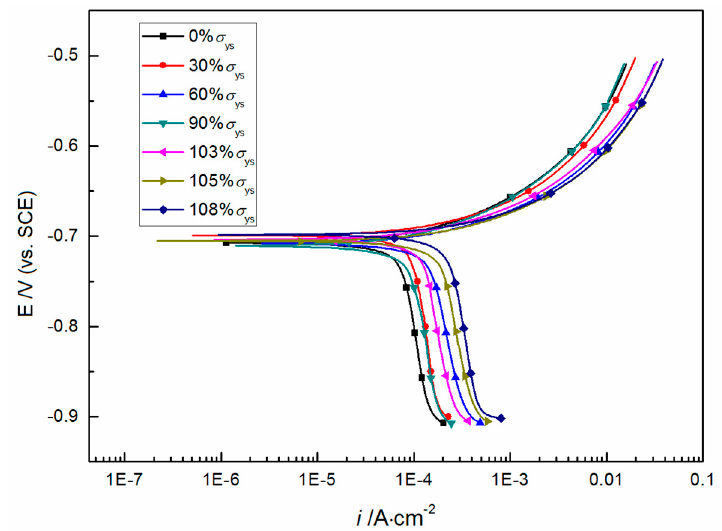
Figure 5. Potentiodynamic polarization curves of X80 steel exposed to 3.5 wt% NaCl aqueous solution with saturated CO 2 at 30 ◦ C under different elastic and plastic tensile